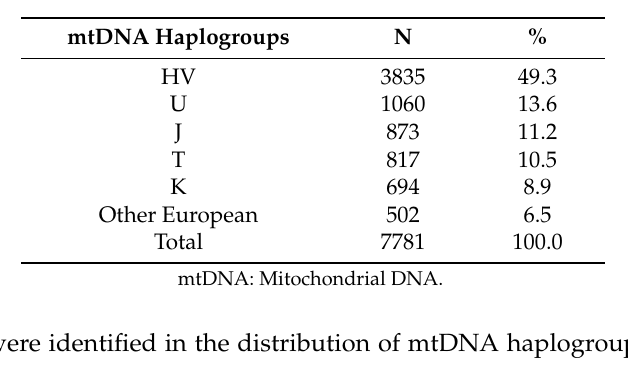
Table 1. European mitochondrial DNA haplogroups in mothers and children of the Avon Longitudinal Study of Parents and Children (ALSPAC) used in the analysis of breast cancer risk factors (quality score >